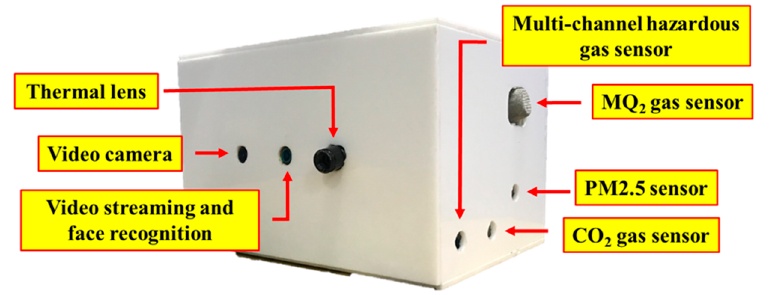
Figure 4. A multipurpose monitoring system in a box—iMonitor. Table 3. UAV modules.